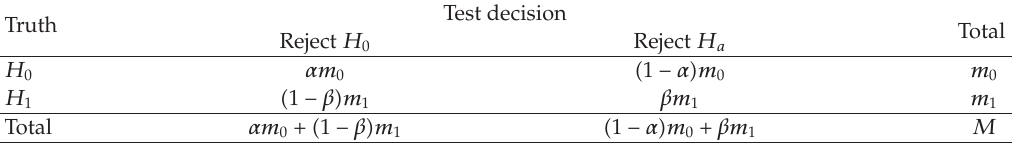
Table 3: Expected outcome for testing M